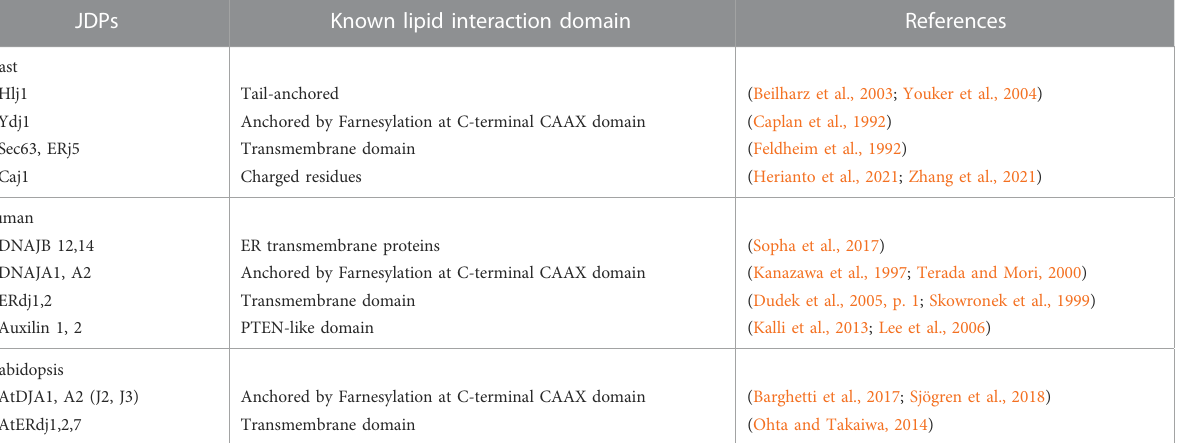
TABLE 1 List of Lipid interacting cytosolic